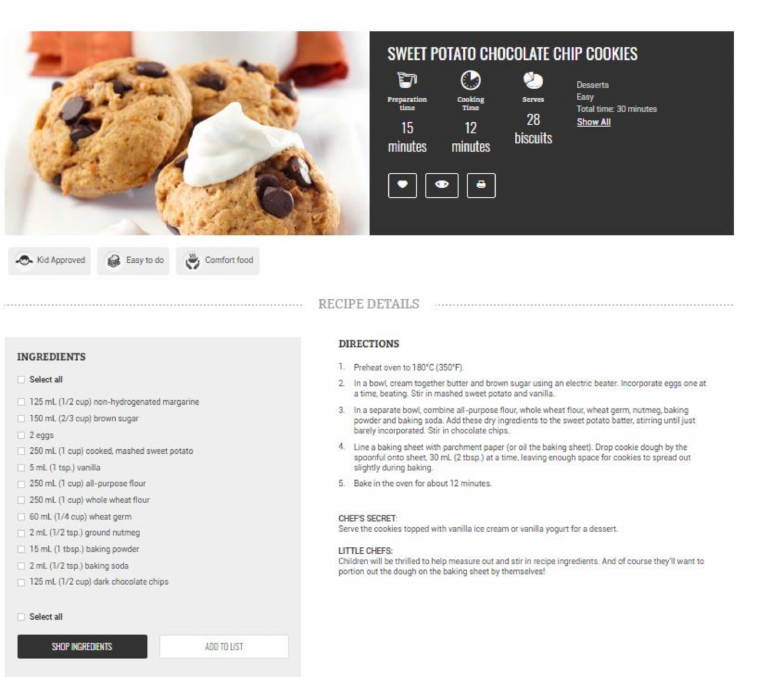
Figure A3. Recipe used for the condition with High arithmetic complexity and search